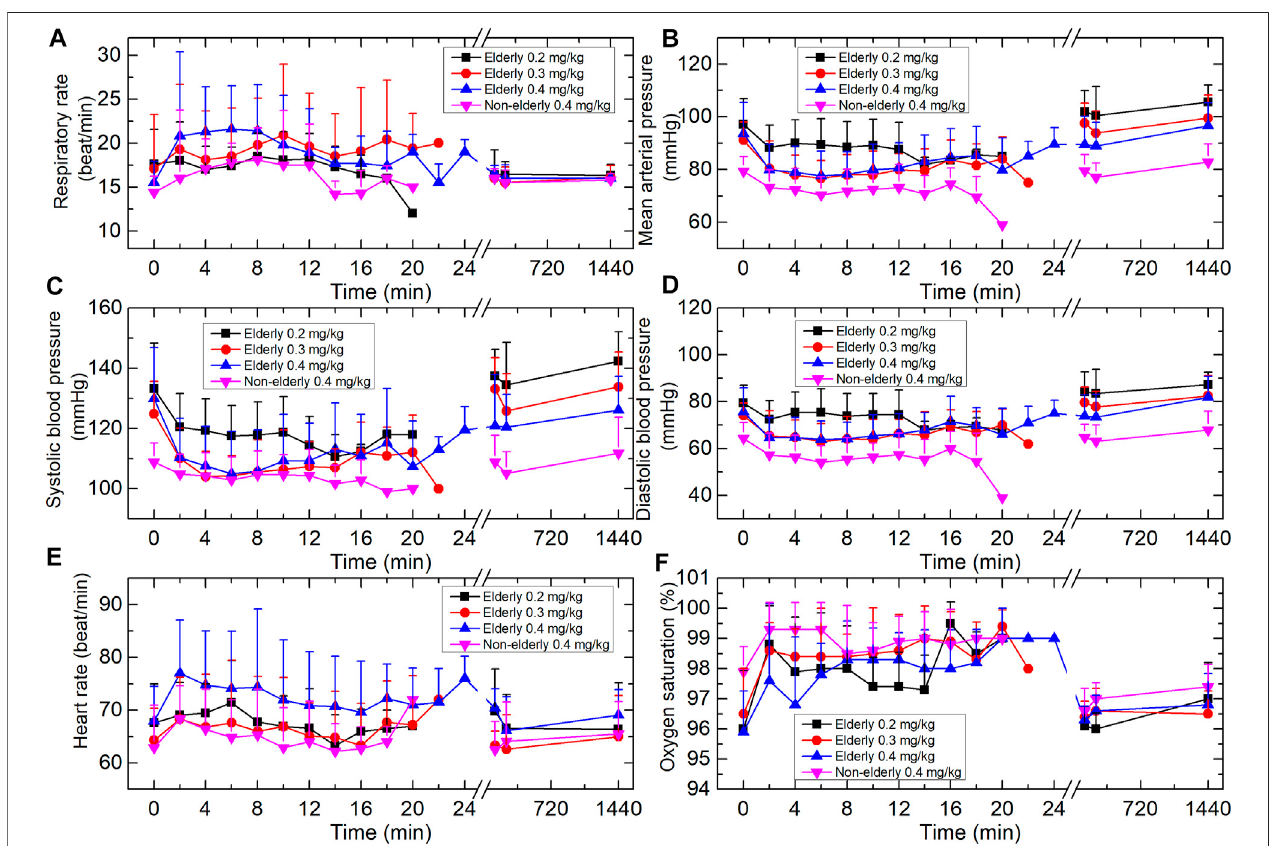
FIGURE 2 | Vital signs of the four groups. (A) Respiration rate. (B) Mean arterial pressure. (C) Systolic blood pressure. (D) Diastolic blood pressure. (E) Heart rate. (F) Oxygen saturation (SpO2). Data are reported as mean + standard deviation.